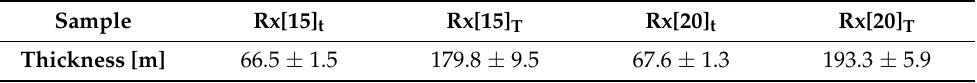
Table 2. Thickness of radiation-crosslinked hydrogel (RXgel) layer coated on vascular grafts. Sample